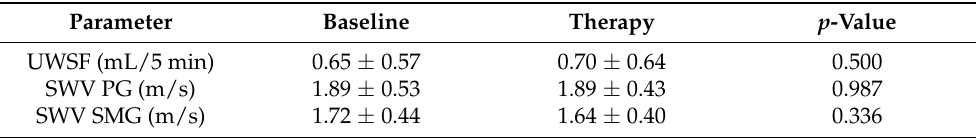
Table 4. Glandular function and glandular stiffness (UWSF = unstimulated whole salivary flow, SWV = shear wave velocity, PG = parotid gland, SMG = submandibular gland). Parameter Baseline